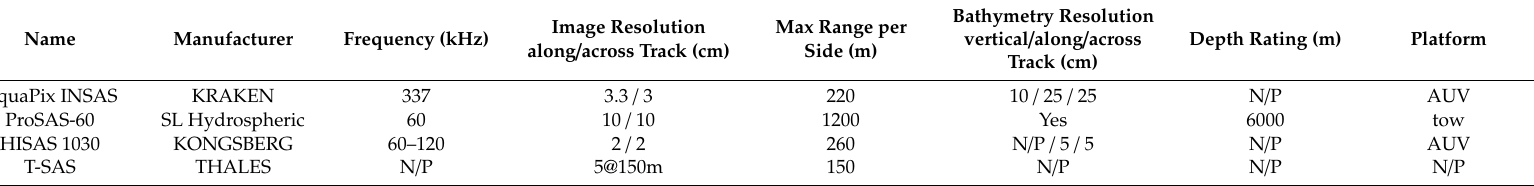
Table 8. Acoustic sensor: synthetic aperture sonar (SAS).